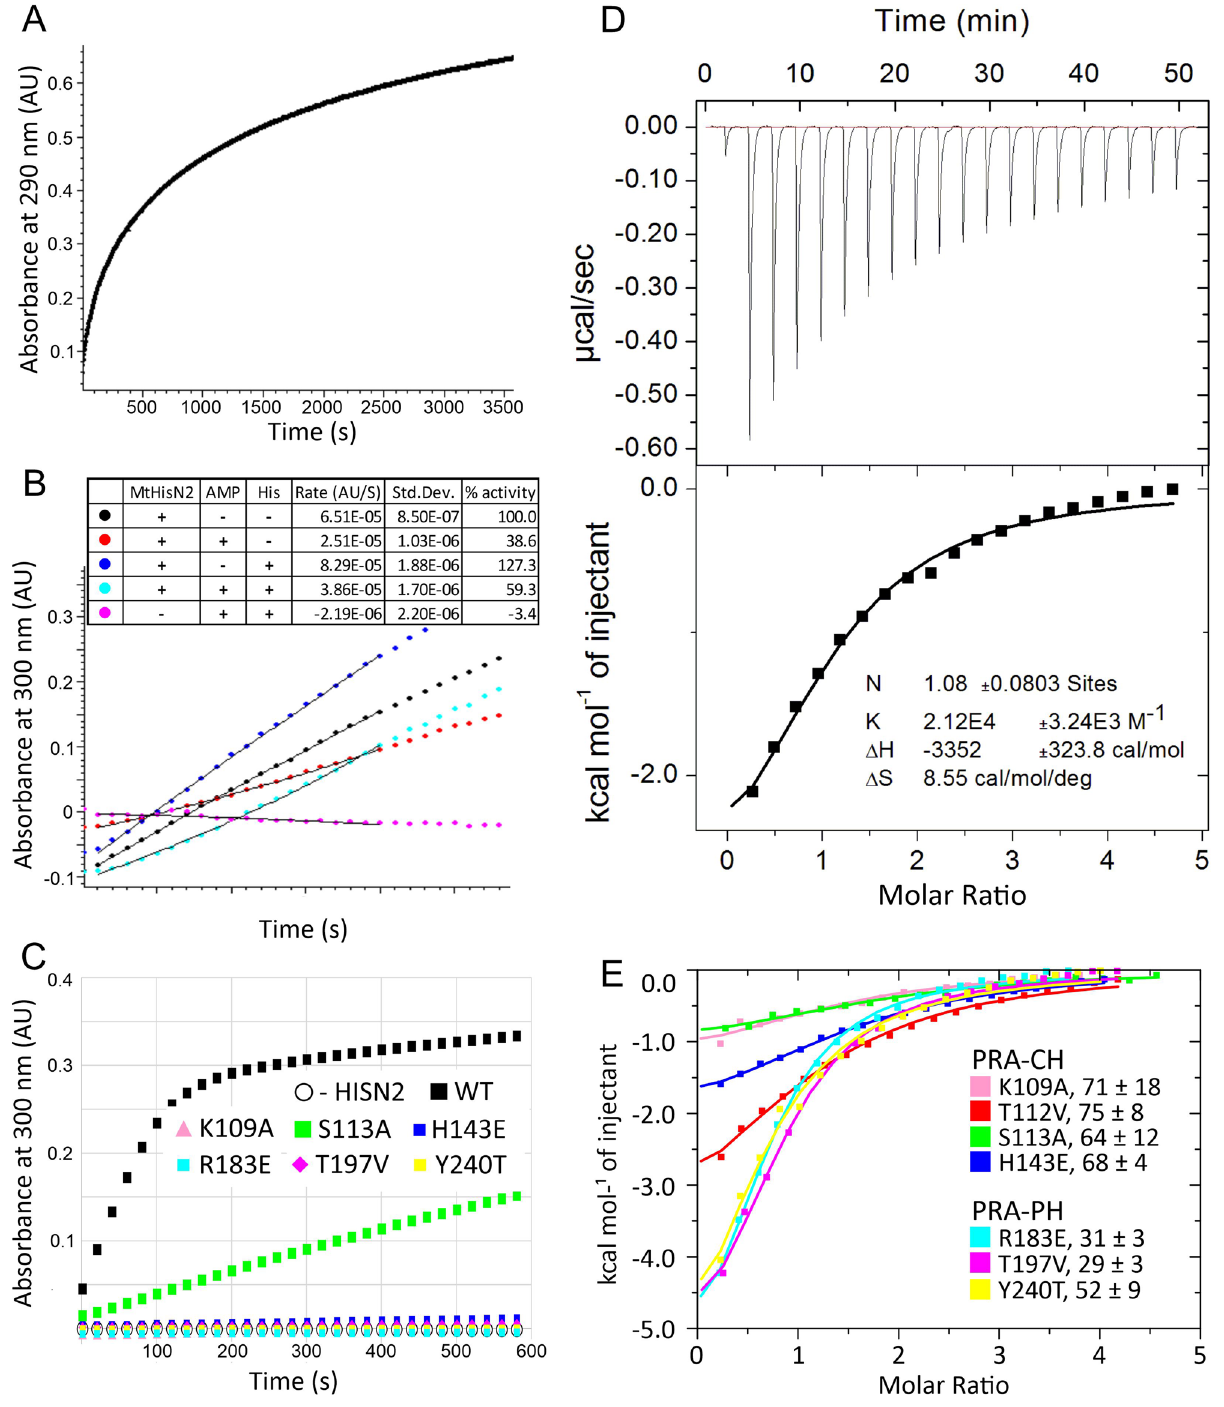
Figure 7. Mt HISN2 activity measurements. Panel A shows the course of enzymatic PR-ATP production. Results of the AMP (at 100 μM concentration) inhibition assay, in the presence and absence of histidine (100 μM), are presented in panel B ; ProFAR increase was monitored at 300 nm. Panel C illustrates relative activities of the wild-type Mt HISN2 and its point mutants. Microcalorimetric study of the interaction between Mt HISN2 and AMP is shown in panels D–E . Representative ITC results for the wild-type protein is shown in panel D ; the raw data are in the upper part, while the bottom part shows the best fit of one sets of binding sites model to the integrated peaks. Panel E shows AMP binding properties of the Mt HISN2 point mutants; K d values ± errors are shown for each mutant in